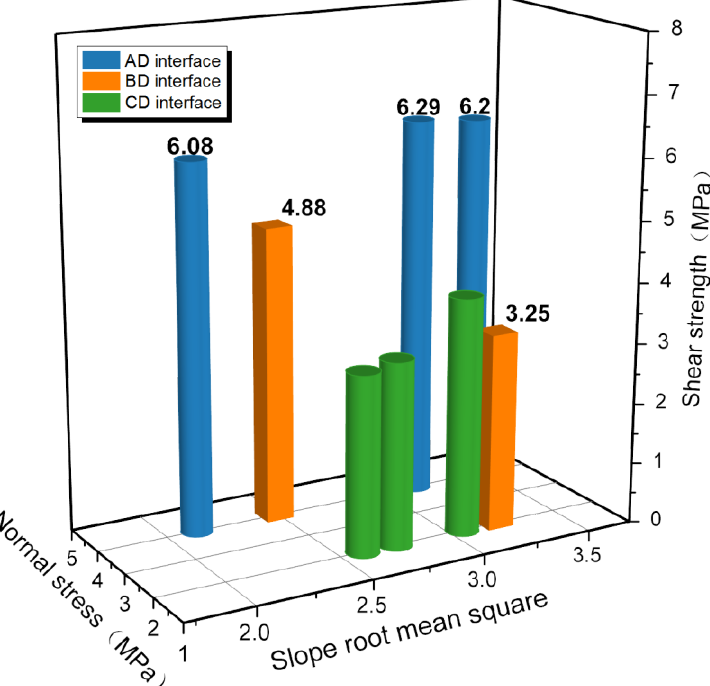
Figure 15. Relation between slope root mean square and shear strength.